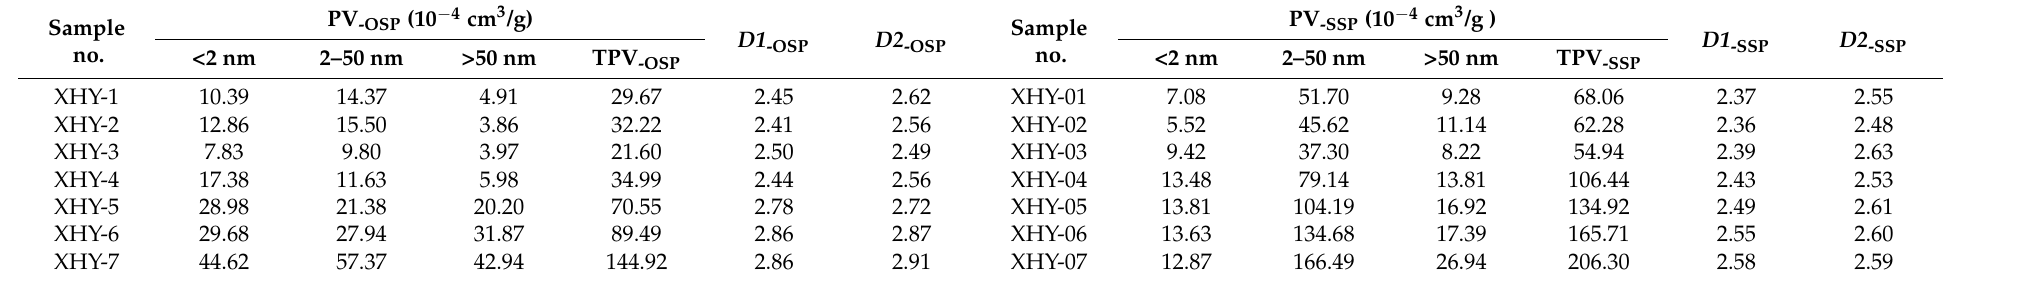
Table 3. PSD and fractal dimension of shale samples based on open and semi-closed pyrolysis experiments.